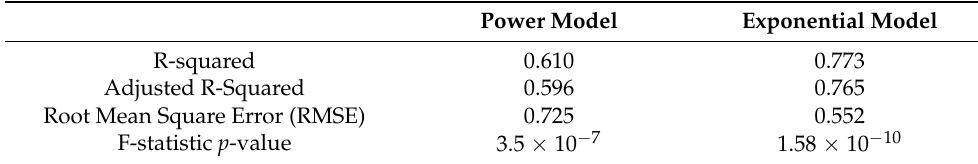
Table 3. Power and exponential models, relationship between the settlement area and population.